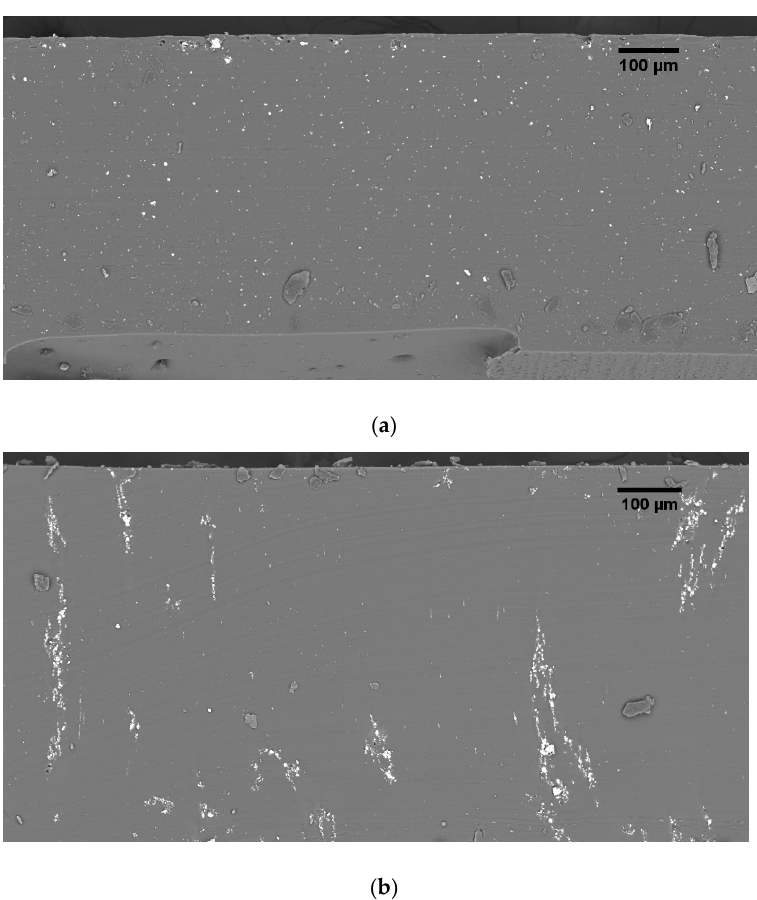
Figure 4. SEM images of the cross section of PZT/PDMS composite with 1% vol of filler : ( a ) 0–3 connectivity; ( b ) 1–3 connectivity. 3 connectivity; ( b ) 1–3